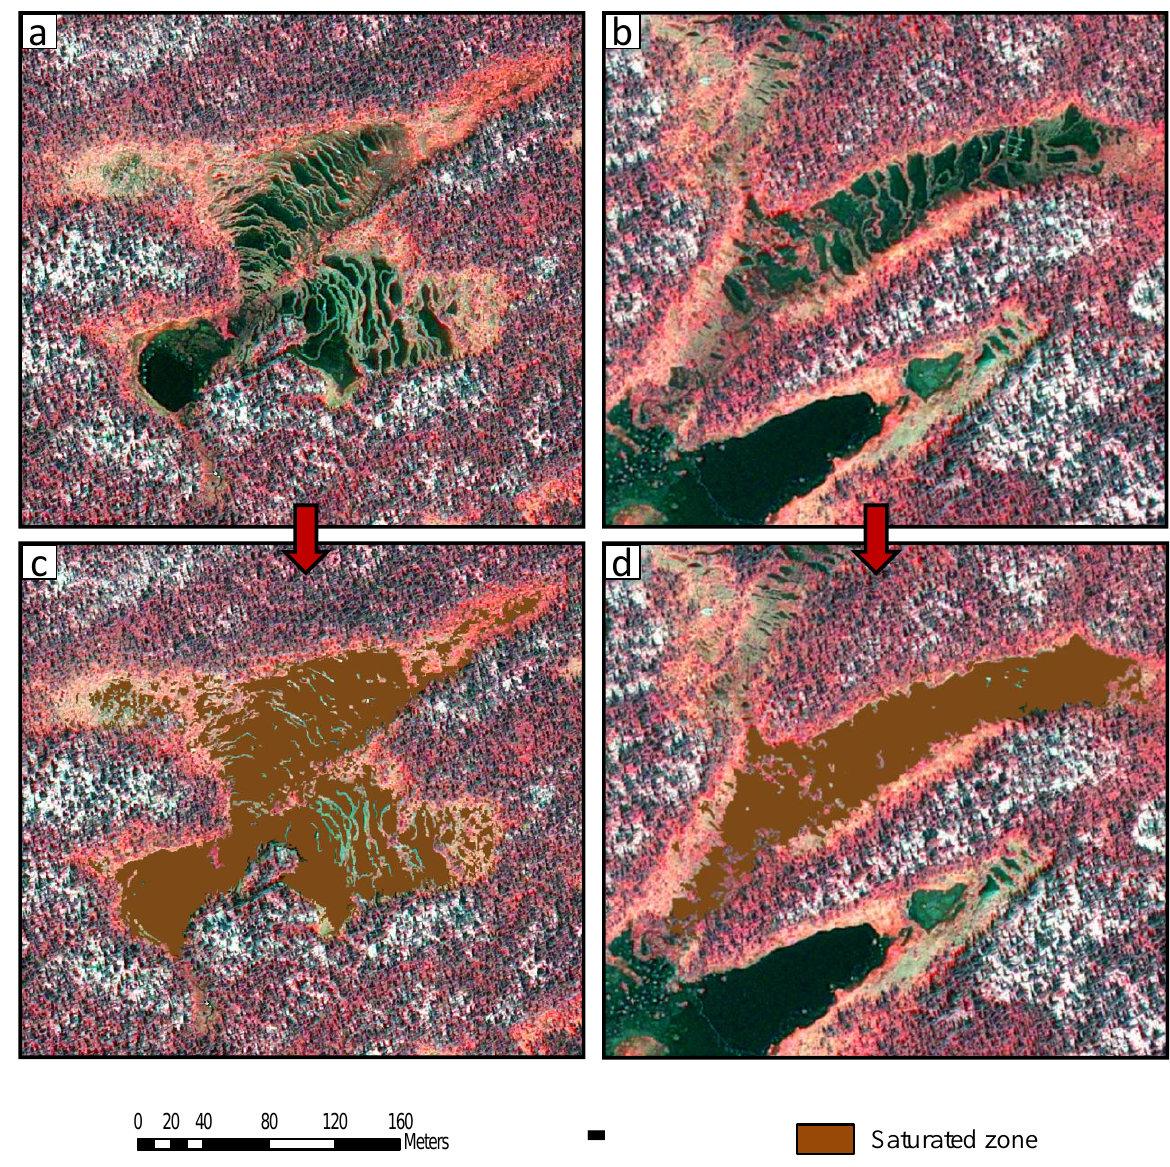
Figure 6. False colored composite (NIR, Red, Green) of two 3 August 2010 GeoEye-1 subsets centered on ( a ) site 1 (54°06′52″N, 72°30′02″W) and ( b ) site 2